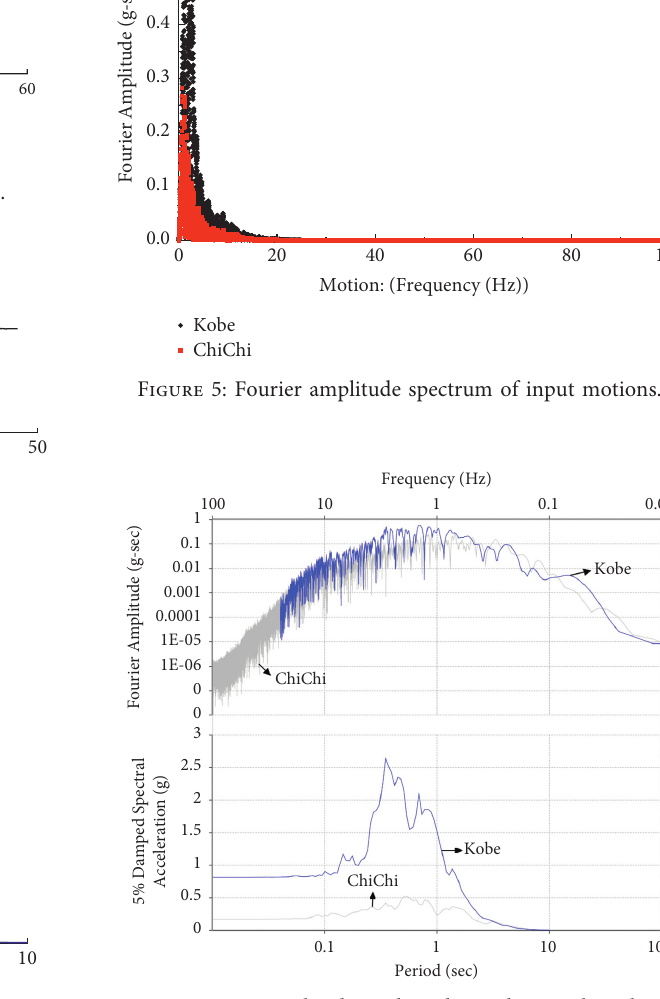
Figure 6: Fourier amplitudes and 5% damped spectral acceleration of two input seismic